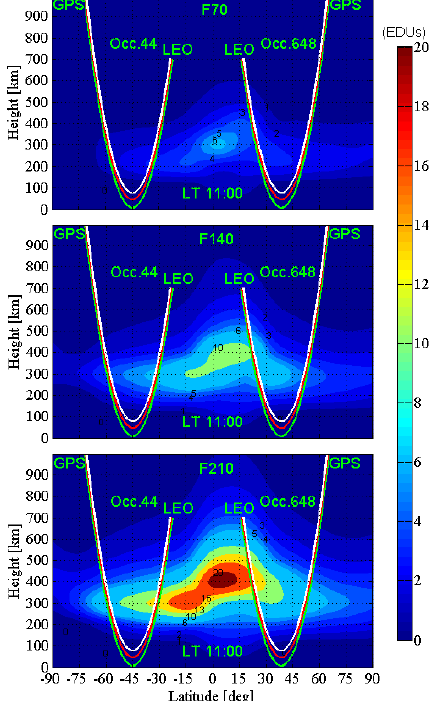
Figure 4. Cross-sectional views of vertical electron density (1 elec- tron density unit (EDU) = 10 11 electronsm − 3 ) along the Occ.44 and Occ.648 occultation event planes (latitudinal vertical plane ex- tracted from the NeUoG model at 11:00LT) at three solar activity levels (F10.7 = 70, 140, 210). Three representative ray paths of each event – the lowest ray path (green), stratopause ray path (red) and mesopause ray path (white) – correspond to the heights of tangent points at 10, 50 and 80km,